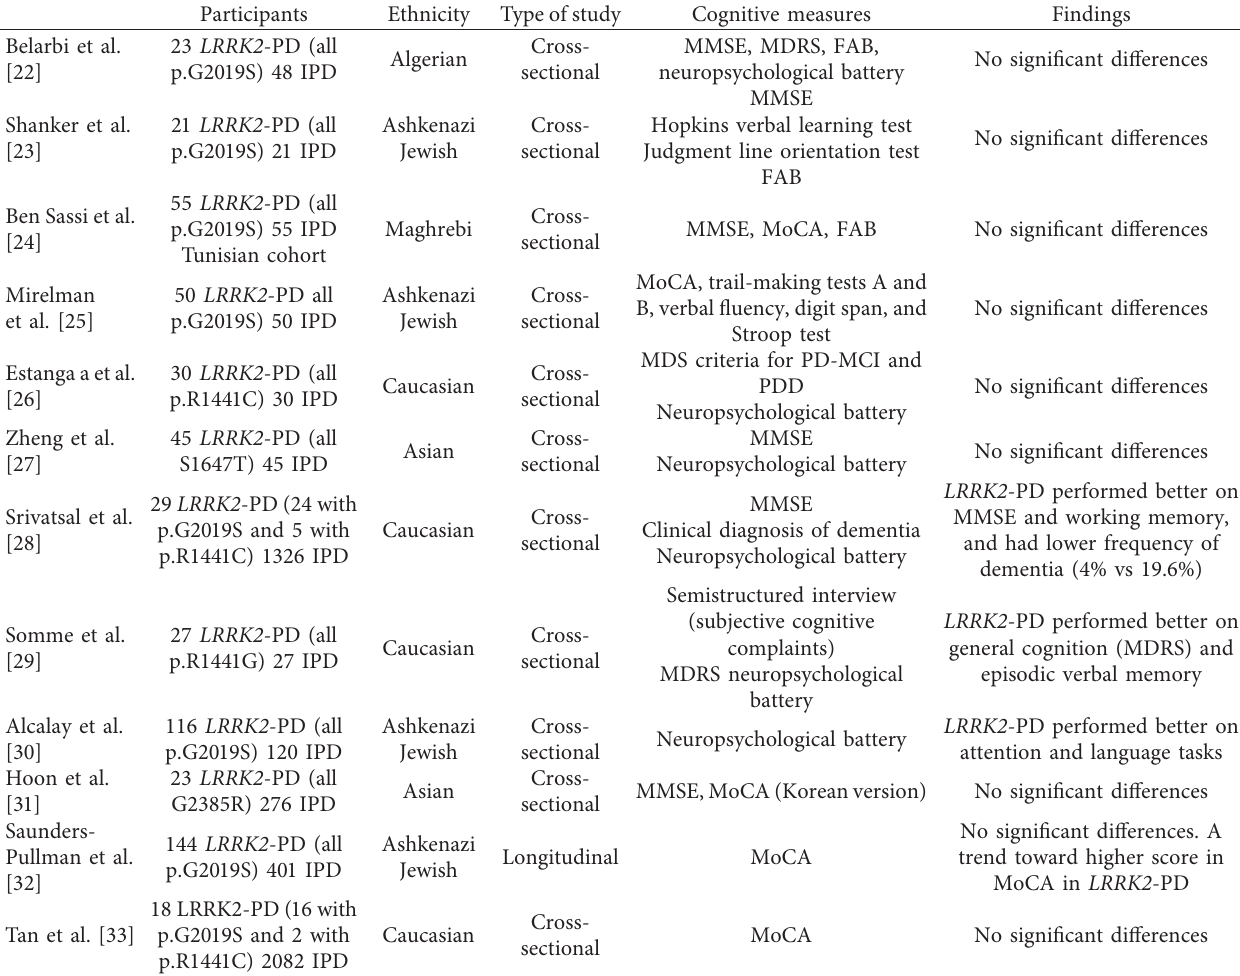
Table 1: Studies assessing cognition in LRRK2 -associated